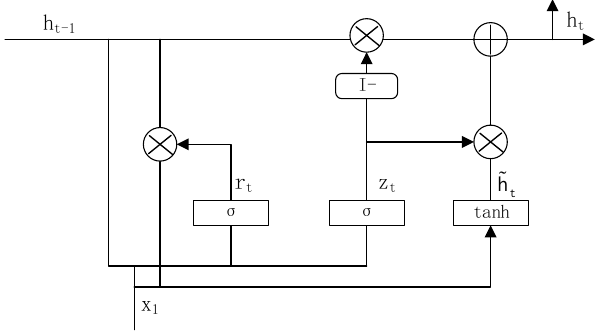
Figure 3. The GRU structure diagram.